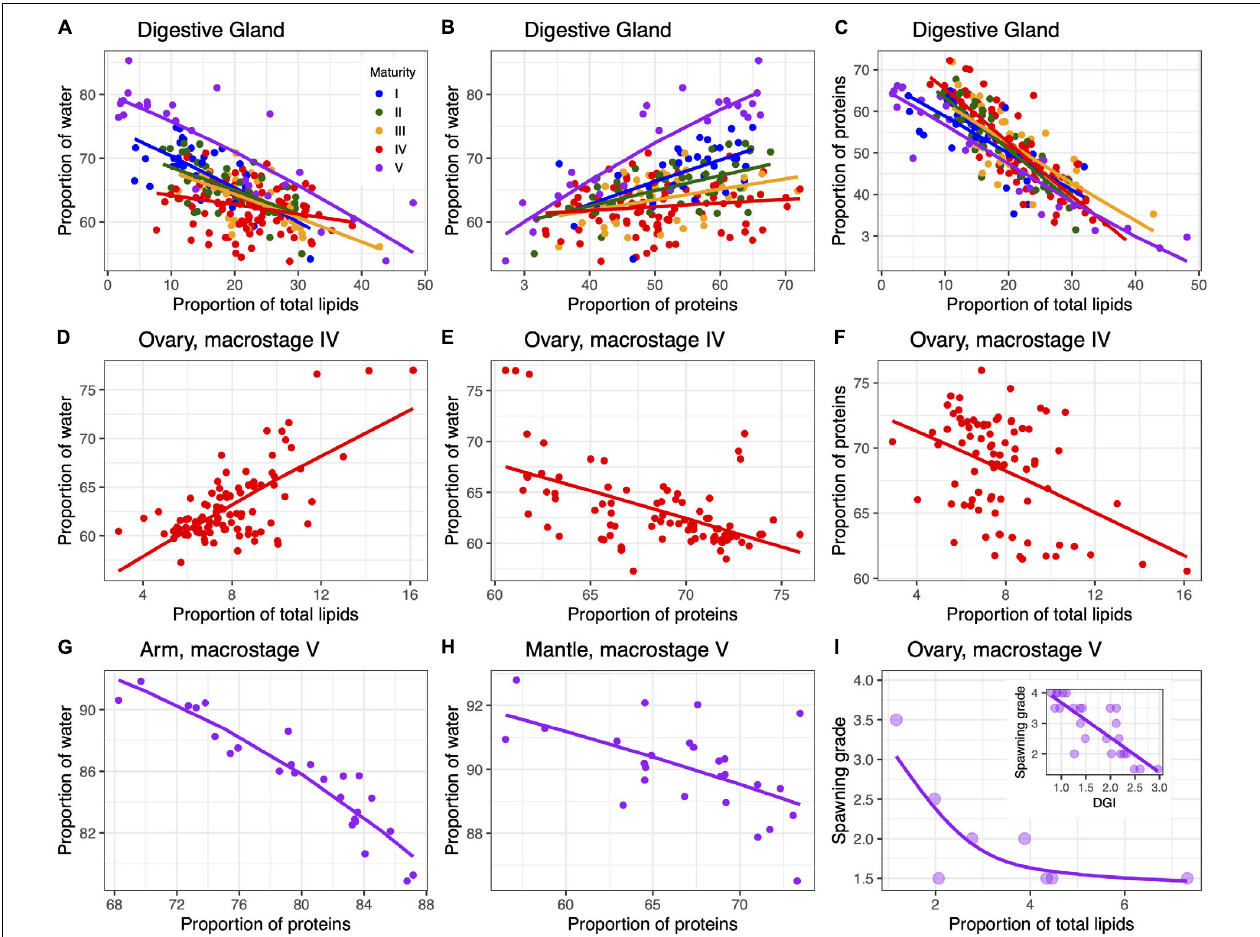
FIGURE 4 | Scatterplots showing the relationships between the proportion of water, total lipids and total proteins for all maturity stages in the digestive gland (A-C) , in macrostage IV ovaries (D-F) , and macrostage V in the arm (G) and mantle (H) . Shown is also the relationship between total lipids (and condition index, DGI) with the spawning grade in macrostage V ovaries (I) . Lines show beta regression fits with the exception of panel (I) that shows GAM fits. See Supplementary Table 3 for numerical